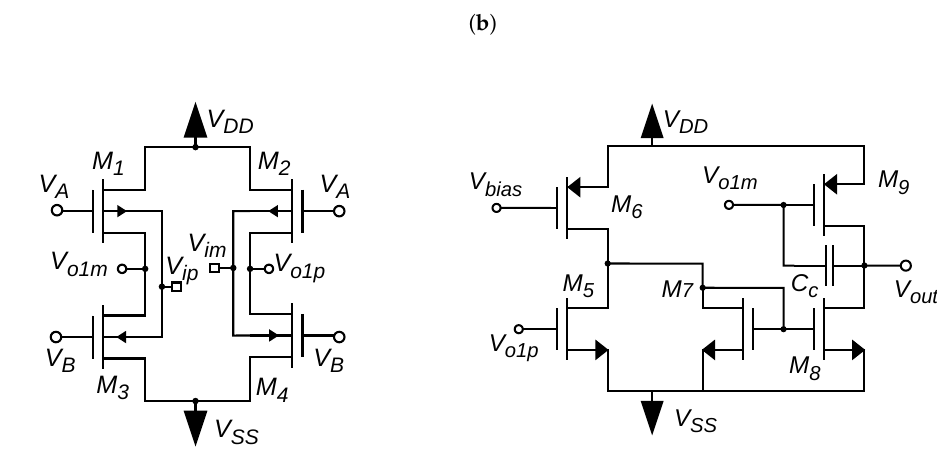
Figure 1. Schematic of the proposed amplifier: ( a ) first stage fully differential amplifier; ( b ) second stage differential to single ended amplifier.